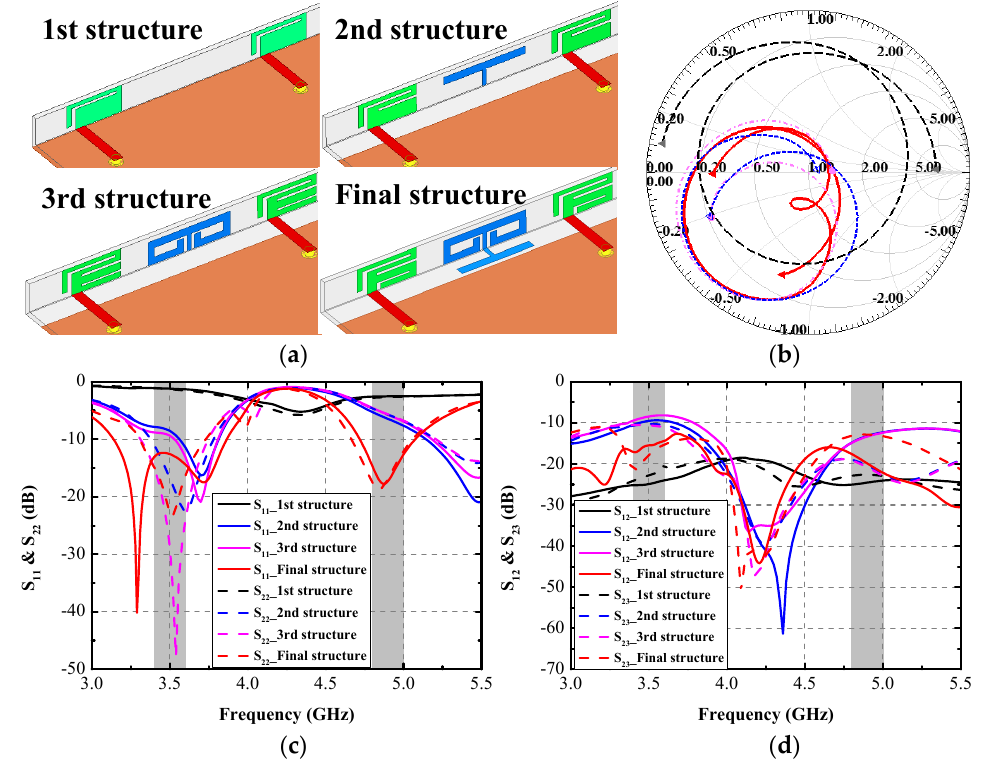
Figure 2. ( a ) Design evolution, ( b ) simulated Smith chart of S 11 , ( c ) simulated S 11 and S 22 , ( d ) simu- lated S 12 and S 23 . Table 1. The simulated normalized impedance at two resonant frequencies of each design stage.